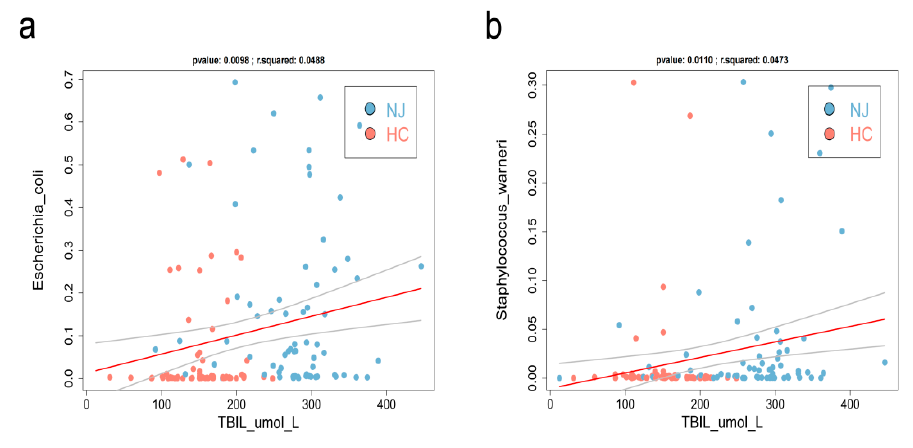
Figure 6. Gut bacteria/clinical indicators association analysis. The gut microbiota affects bilirubin metabolism. We performed a correlation analysis between the gut bacteria and neonatal clinical indicators/bilirubin. The linear relationship between the gut bacteria and clinical indicators was ana- lyzed using the lm function in the regression analysis package of R software (version 4.0). Spearman rank correlation and statistical significance tests were performed using the cor and cor.test functions in R, respectively. Higher neonatal bilirubin values yielded wider distributions of Staphylococcus ( b ) and Escherichia coli ( a ), and p < 0.05 was considered statistically significant.